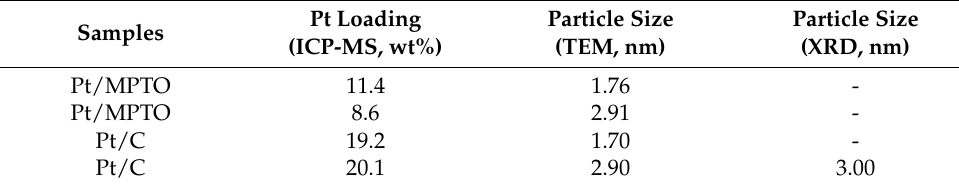
Figure 6. TEM images and particle size histograms of ( a – c ) Pt/MPTO and ( d – f ) Pt/C. Table 2. Pt loading, TEM particle size and XRD particle size